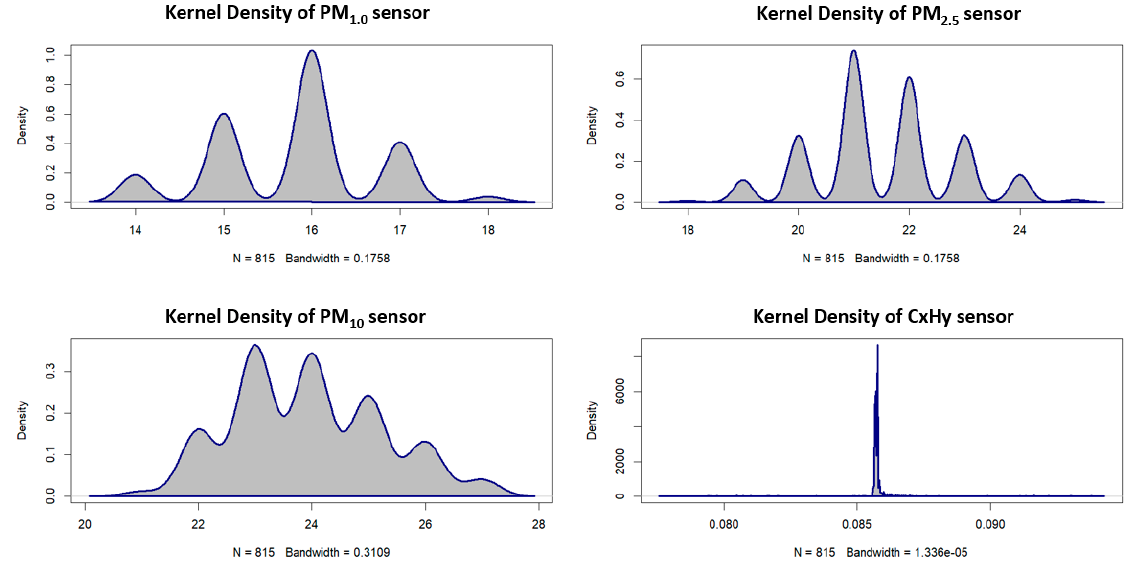
Figure A7. Kernel density for UAV measurement (VOCs sensor, SO 2 sensor, CO sensor, O 3 + NO 2 sensor).